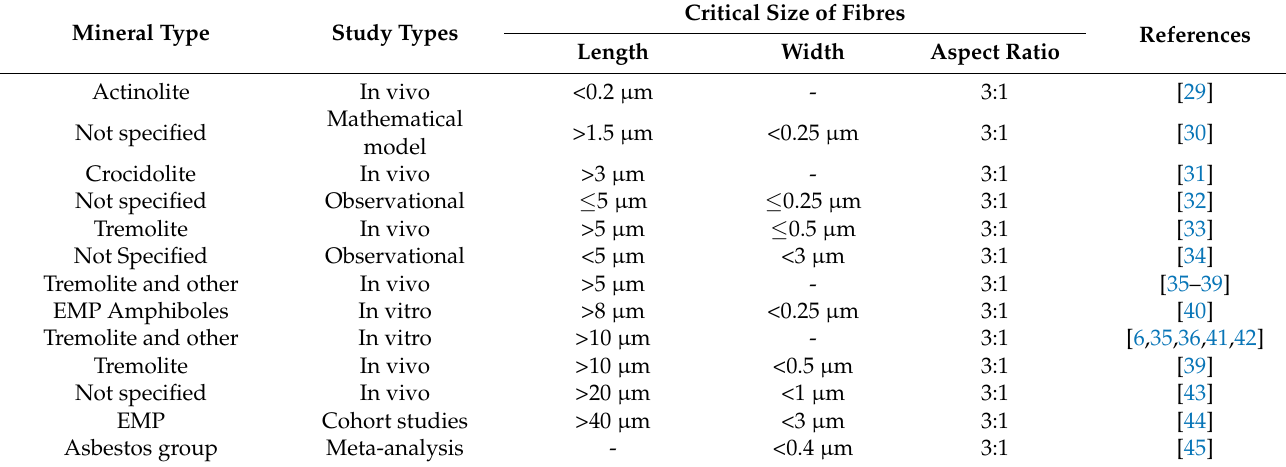
Table 1. Synoptic table showing fibre dimensions that are the most liable to contribute to lung cancer risk. Mineral